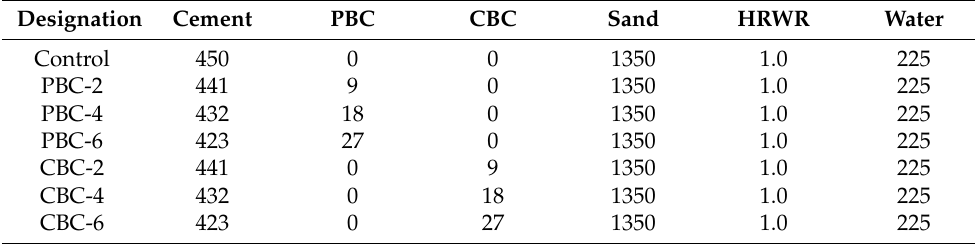
Table 1. Mixture design of concrete with biochar (kg/m 3 ).